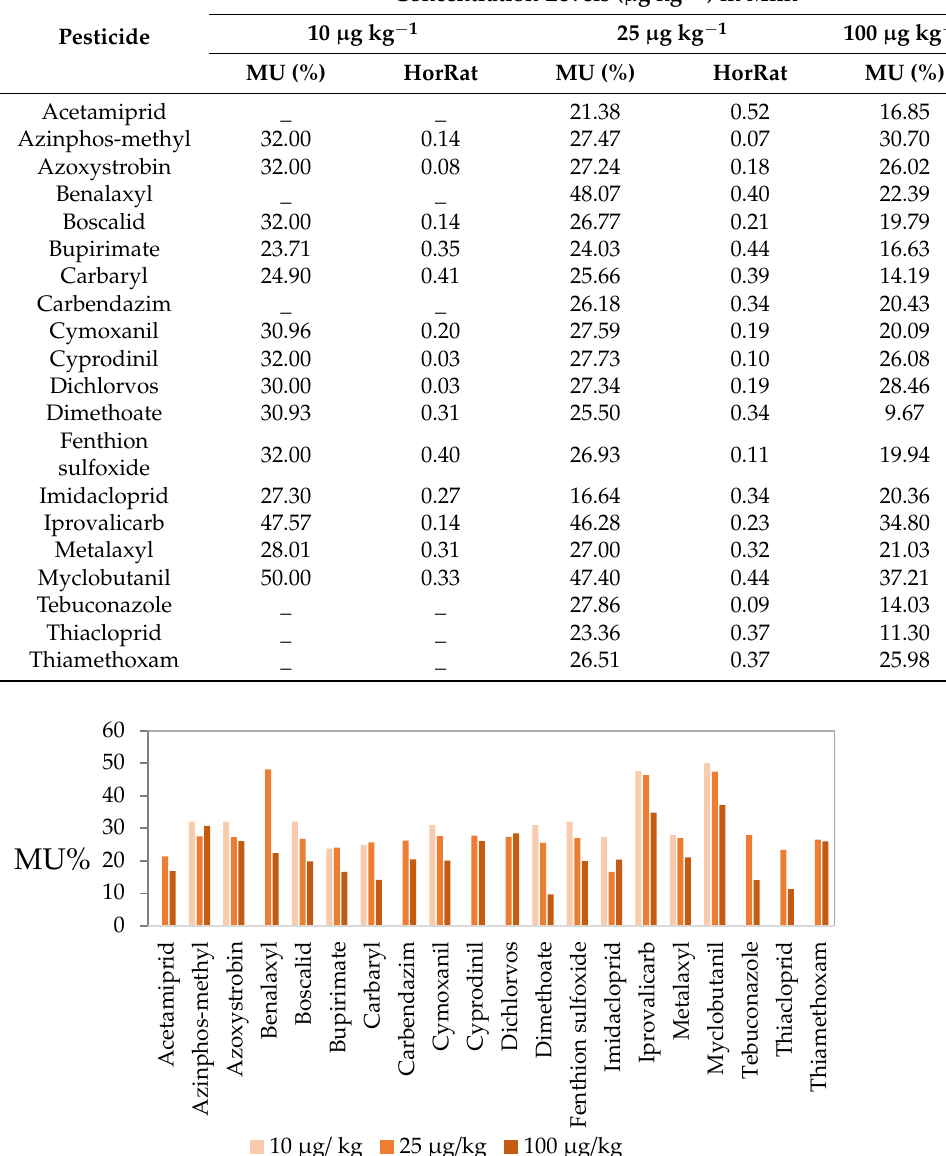
Figure 4. Measurement uncertainty (MU%) for milk in concentrations 10, 25, and 100 μ g kg − 1 . Calculation using the Horwitz equation in 10 μ g kg − 1 fortification level revealed an ac ‐ ceptable PRSD R = 32% and an acceptable PRSD R = 27.88% in fortification level 25 μ g kg − 1 . Table